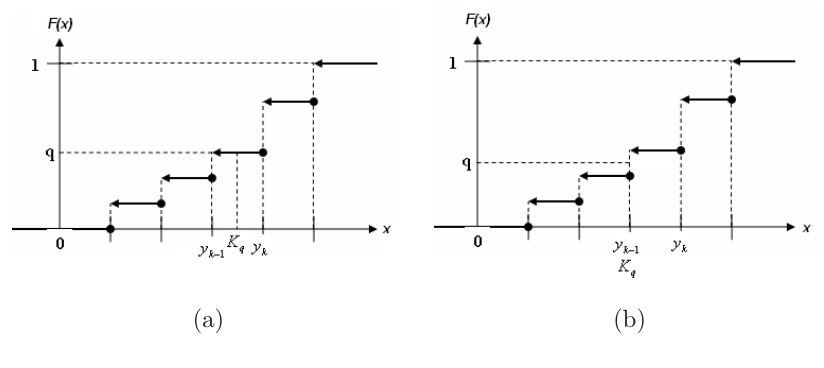
Figure 1. Determination of the population